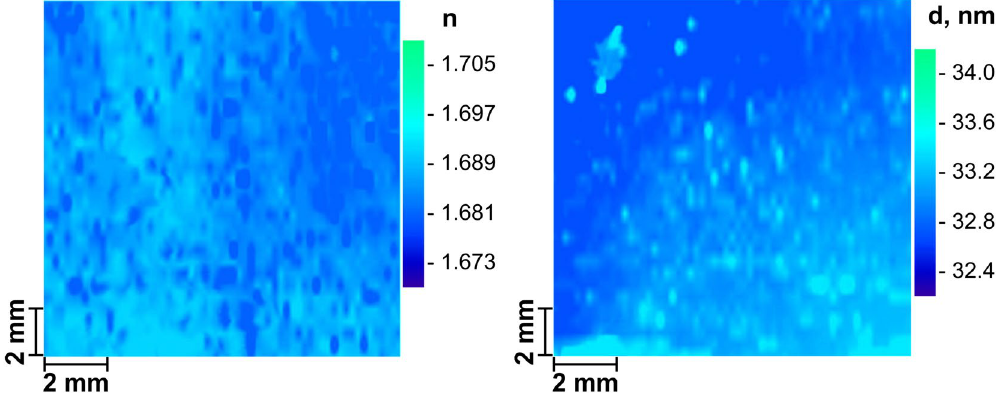
Figure 1. Ellipsometric mapping of refractive index n and thickness d of p + -Si/SiN x /Ni memristor structure (hν = 1.96